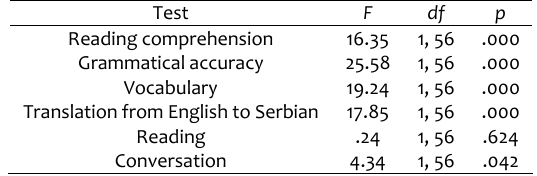
Table 3. Significance of the interaction between Group and Test time for particular tests Test F df p Reading comprehension 16.35 1, 56 .000 Grammatical accuracy 25.58 1, 56 .000 Vocabulary 19.24 1, 56 .000 Translation from English to Serbian 17.85 1, 56 .000 Reading .24 1, 56 .624 Conversation 4.34 1, 56